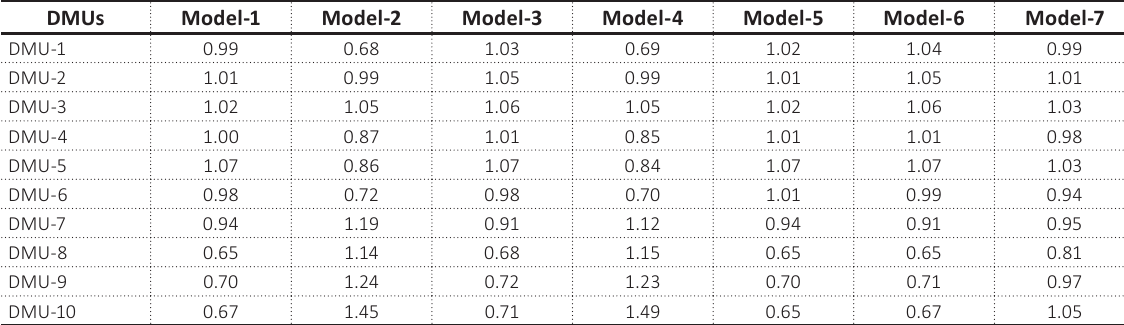
Table 5. The scores of changes in the efficiency of Saudi Arabian